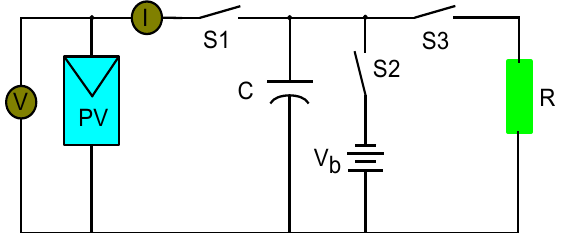
Figure 8. Schematic of a capacitive load tracer. Source [16], own elaboration.